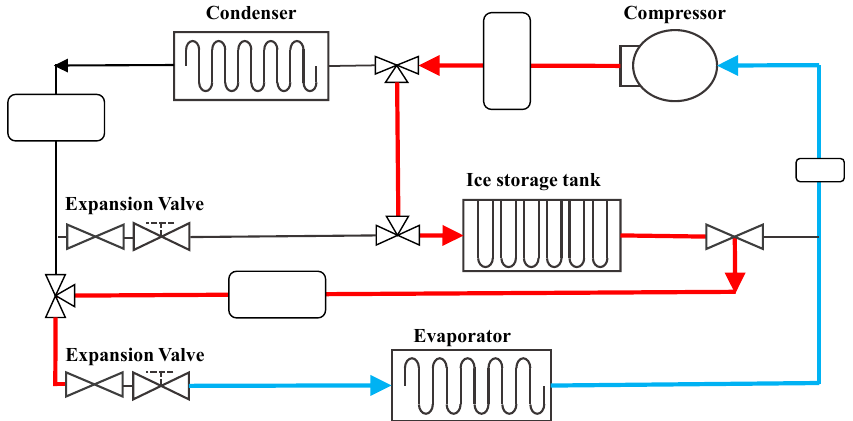
Figure 5. Schematic of the melting mode.